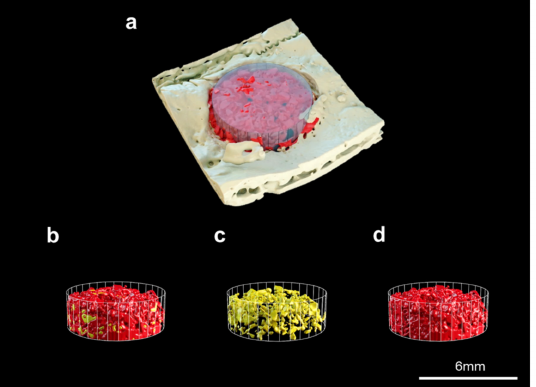
Figure 3. Three-dimensional images of bone volume samples. ( a ) Reconstruction of µ CT data, ( b ) separation of region of interest (ROI), ( c ) bone graft materials, and ( d ) new bones (scale bars = 6